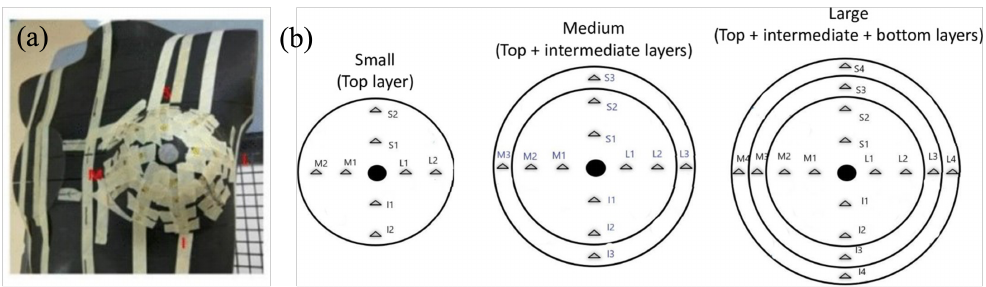
Figure 3. ( a ) The front view of the anthropomorphic phantom with TLDs. ( b ) The illustration of measured points on three different breast